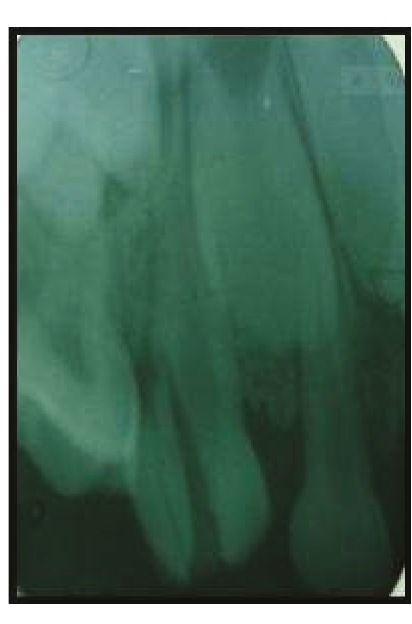
Figure 2: Preoperative radiograph depicts oblique crown-root fracture extending beyond cementoenamel junction.